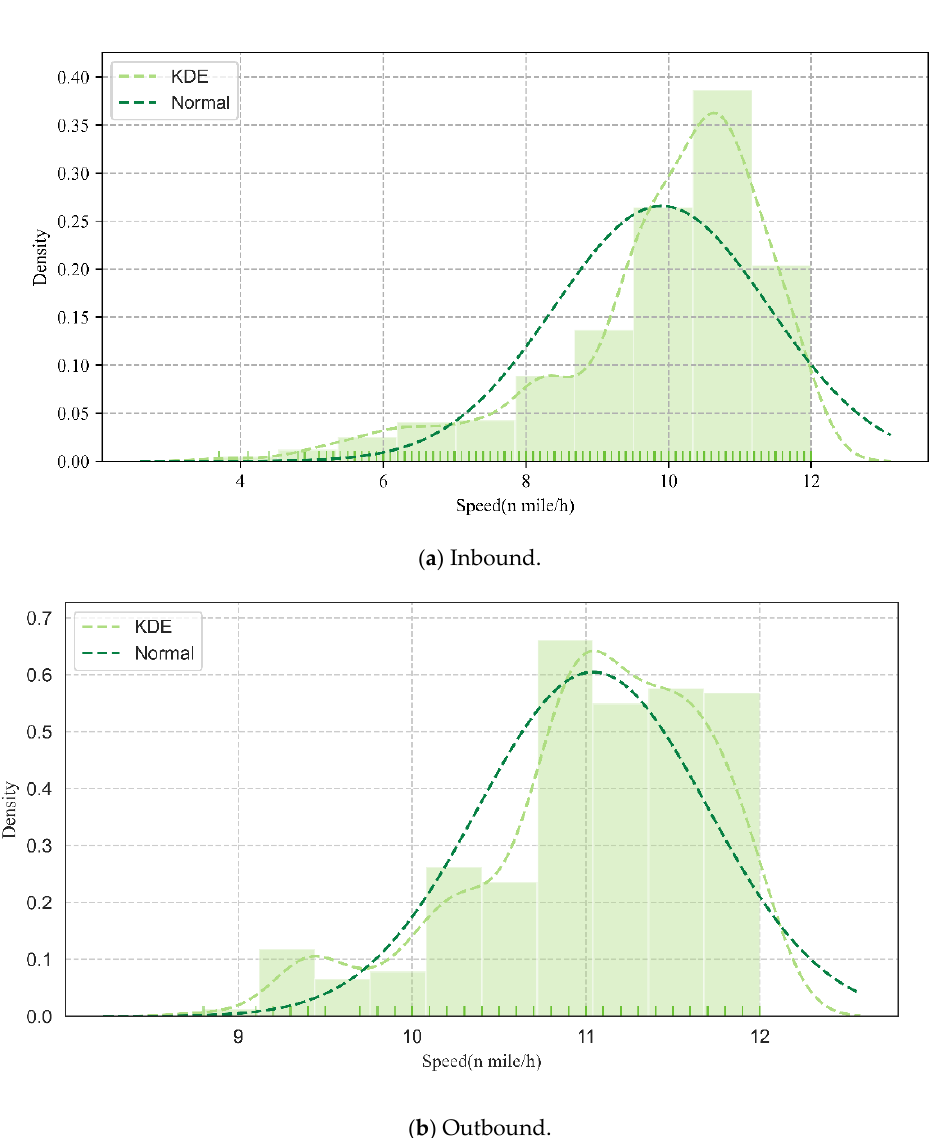
Figure 2. Speed distribution of in-wharf vessels and out-wharf vessels in March 2015. Where the lighter dashed line represents the kernel density distribution curve of speed, the darker dotted line indicates the normal distribution curve of speed, the short solid line indicates the statistical speed data, and the histogram indicates the density distribution of speed intervals.